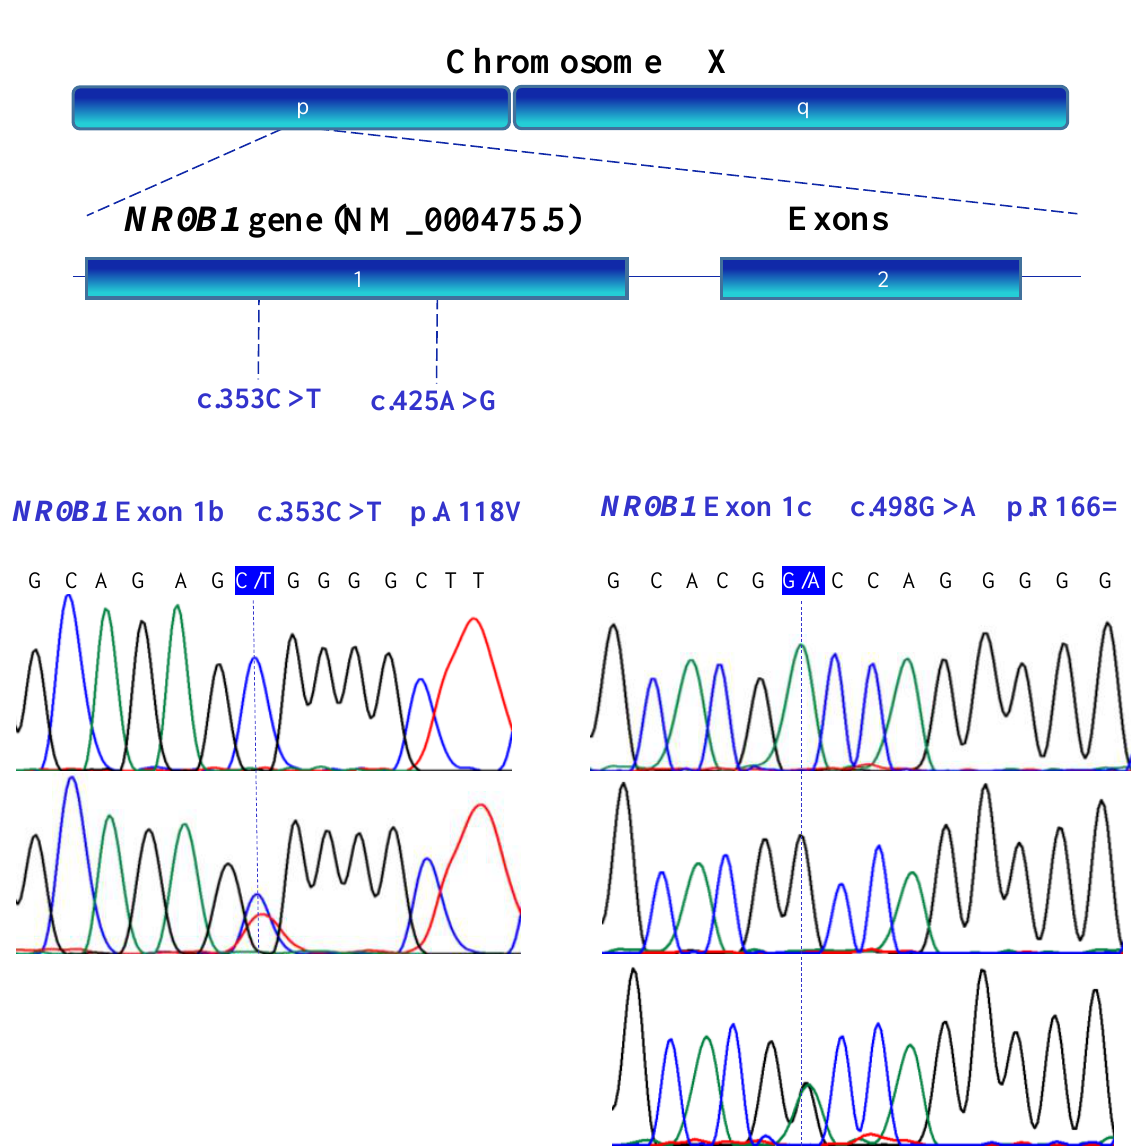
Figure 4. X-chromosome and exon representations of the human NR0B1 (NM_000475.5) gene. Exons (1 and 2) were analyzed by capillary electrophoresis. Human NR0B1 gene sequence variants were identified in exon 1 (blue box) from patients with POI. The presented fragment of the nucleic acid sequence of the NR0B1 gene contains both the non-synonymous and synonymous variants.